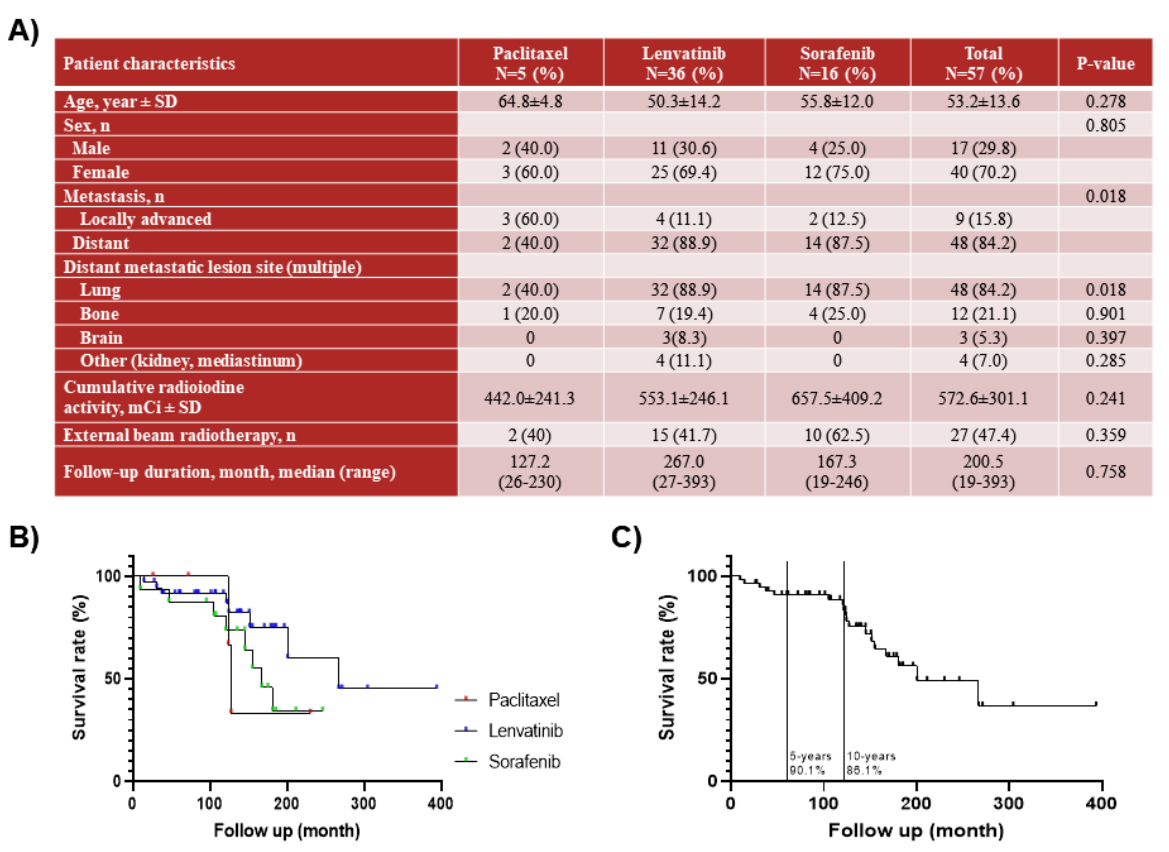
Figure 1. Information on patients with papillary thyroid cancer (PTC) after treatment of paclitaxel, lenvatinib and sorafenib: ( A ) patient characteristics and clinical features, ( B ) overall survival rate after treatment of paclitaxlel, Lenvatinib, and sorafenib, and ( C ) overall survival rate of patients with refractory PTC.